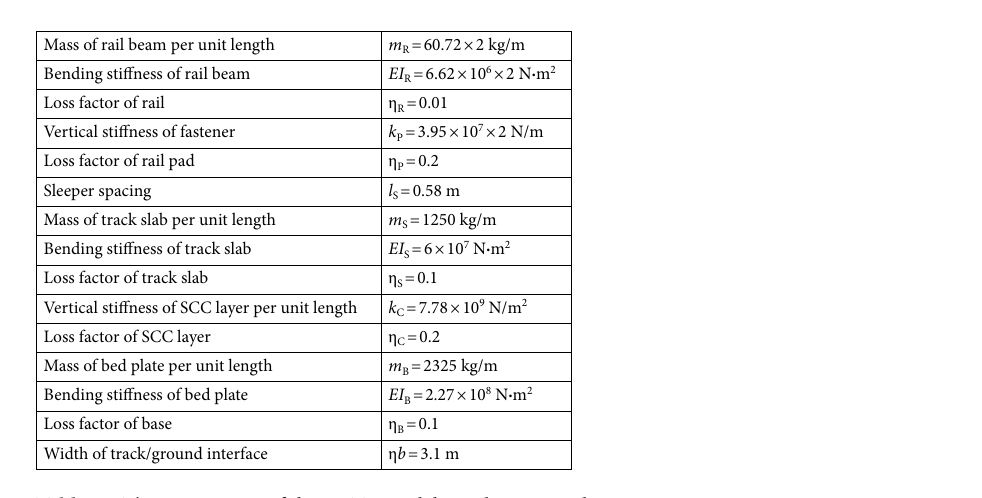
Table 4. The parameters of the CRTS III slab track at normal temperature.